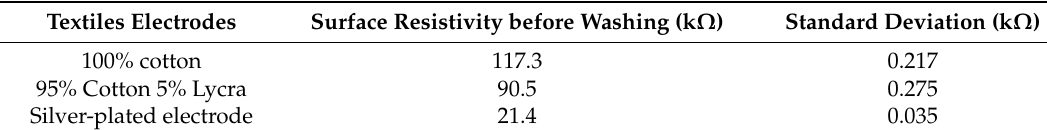
Table 1. Thickness of textile substrate before coating and wt.% of PEDOT:PSS absorbed after drying.